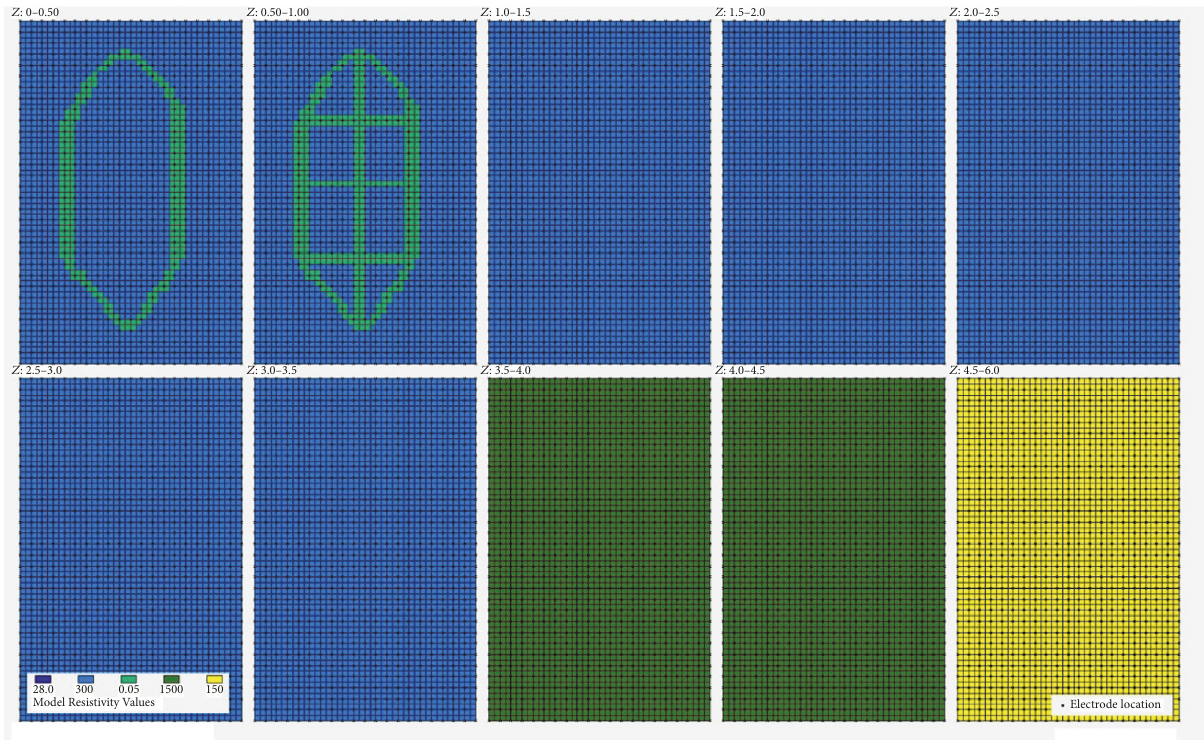
Figure 3: Constitutive parameters of 3D